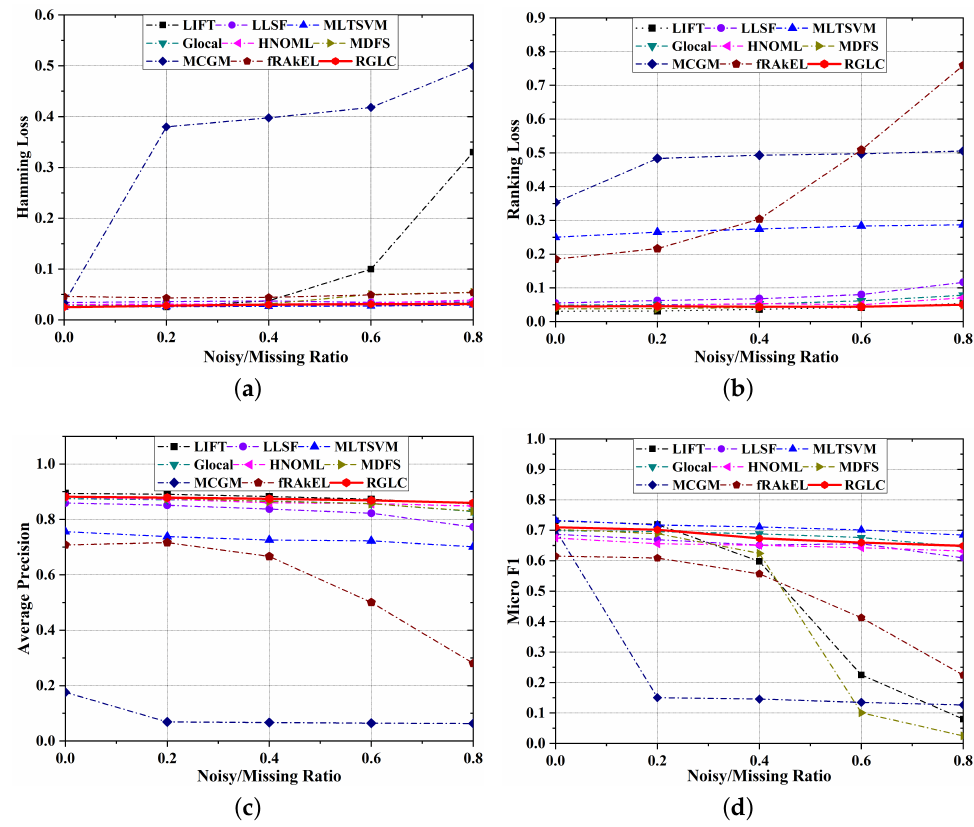
Figure 3. Robustness experiments with noisy features and missing labels on dataset business on metric ( a ) Hamming Loss , ( b ) Ranking Loss , ( c ) Average Precision , and ( d ) Micro F1